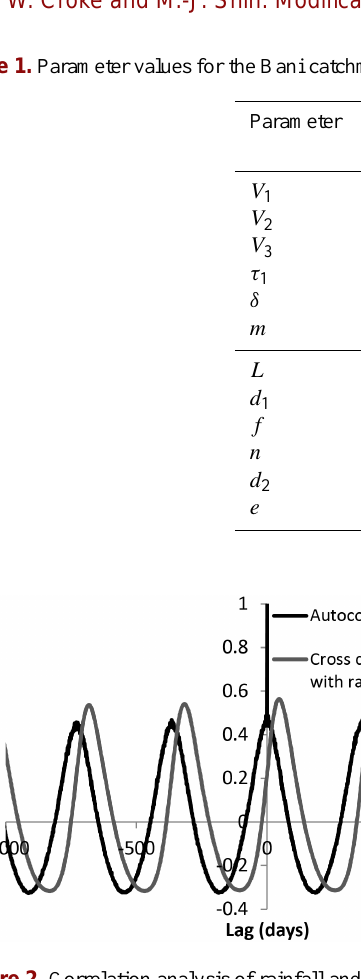
Figure 2. Correlation analysis of rainfall and streamflow